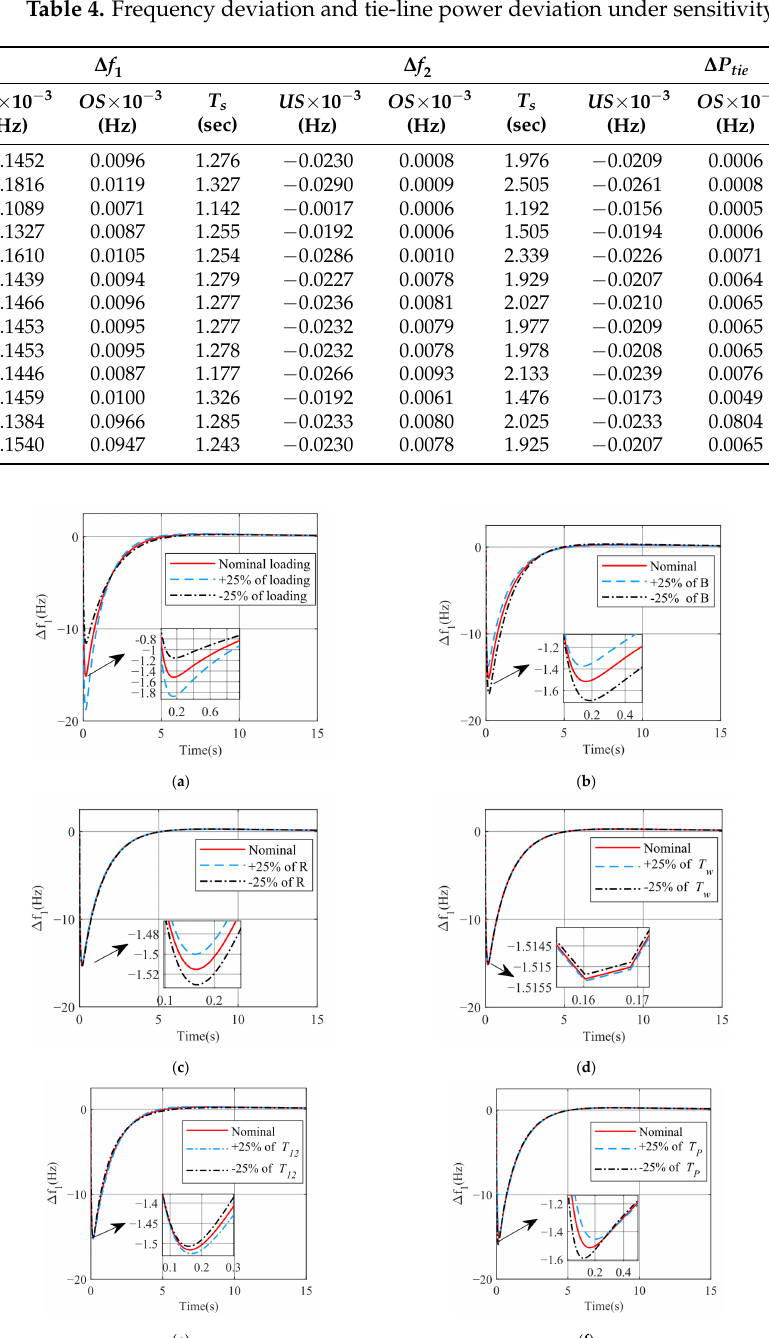
Figure 11. Comparison of robustness results under different load disturbances and system parameters ( a ) ∆ f 1 with change in loading condition, ( b ) ∆ f 1 with change in B , ( c ) ∆ f 1 with change in R , ( d ) ∆ f 1 with change in T w , ( e ) ∆ f 1 with change in T 12 , and ( f ) ∆ f 1 with change in T P